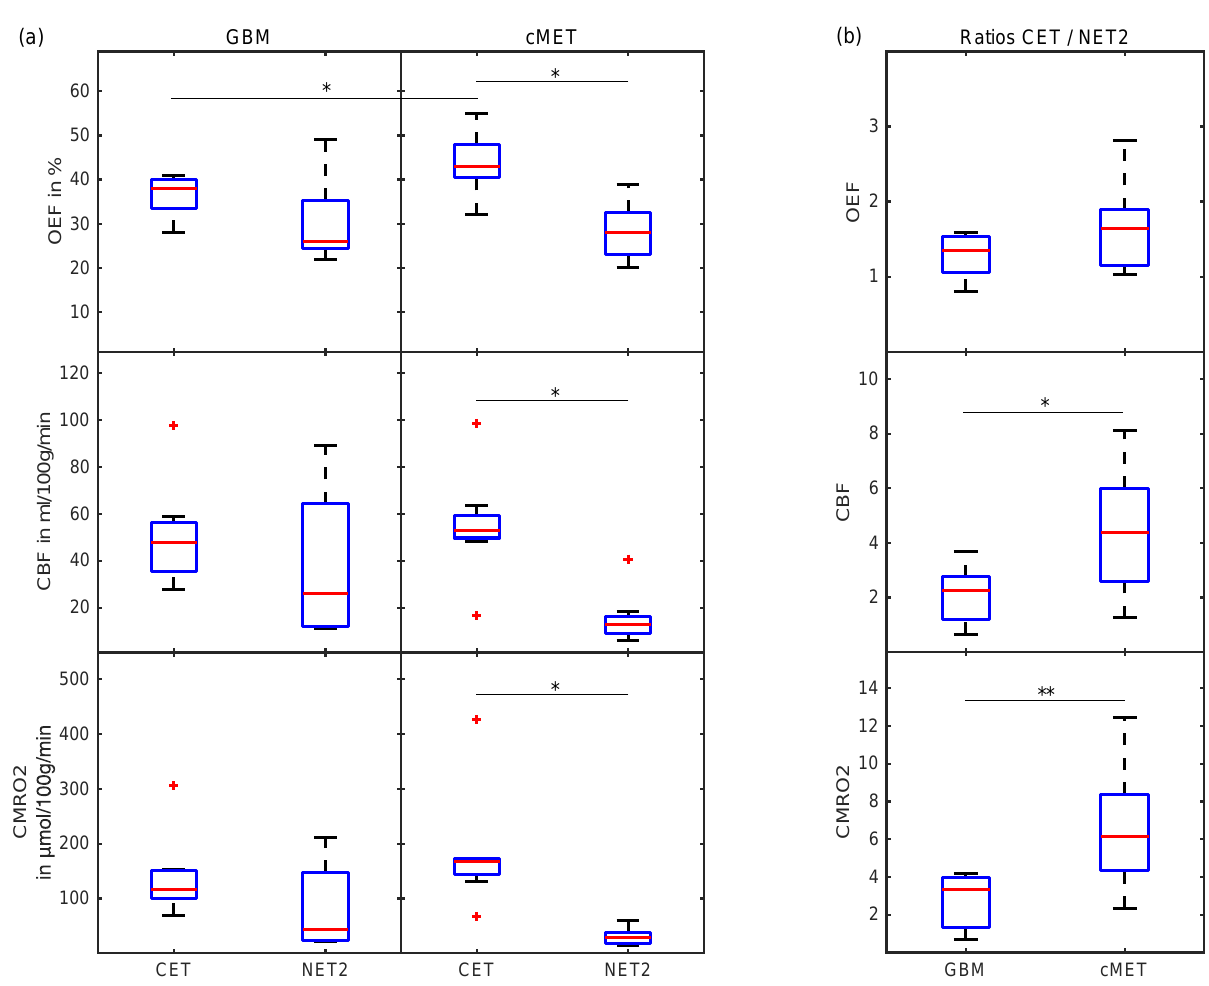
Figure 4. Boxplots ( a ) comparing OEF, CBF and CMRO 2 between CET and NET2 for GBM and cMET and ( b ) displaying the ratios of OEF, CBF and CMRO 2 in CET divided by NET2 for GBM and cMET patients. Box: first to third quartile; whiskers: 1.5 times the interquartile distance or the maximum/minimum value, if contained therein; red line: median. Outliers are displayed as red crosses. Significant differences ( p < 0.05) are marked with an asterisk, the highly significant difference ( p = 0.01) is marked with two asterisks. OEF: oxygen extraction fraction; CBF: cerebral blood flow; CMRO 2 : cerebral metabolic rate of oxygen; CET: contrast-enhancing tumor; NET2: peritumoral non-enhancing T2 FLAIR hyperin- tensity.